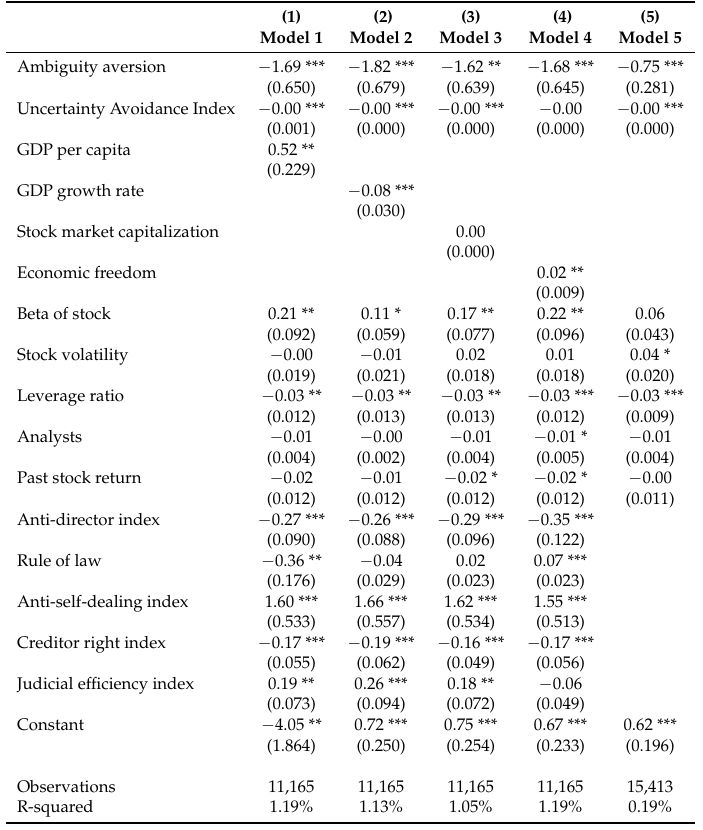
Table 7. The equity premia, ambiguity aversion and the uncertainty avoidance